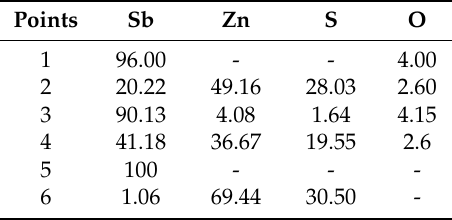
Table 2. EDS results of the elemental contents of the roasted products at the selected points (atom %). Points Sb Zn